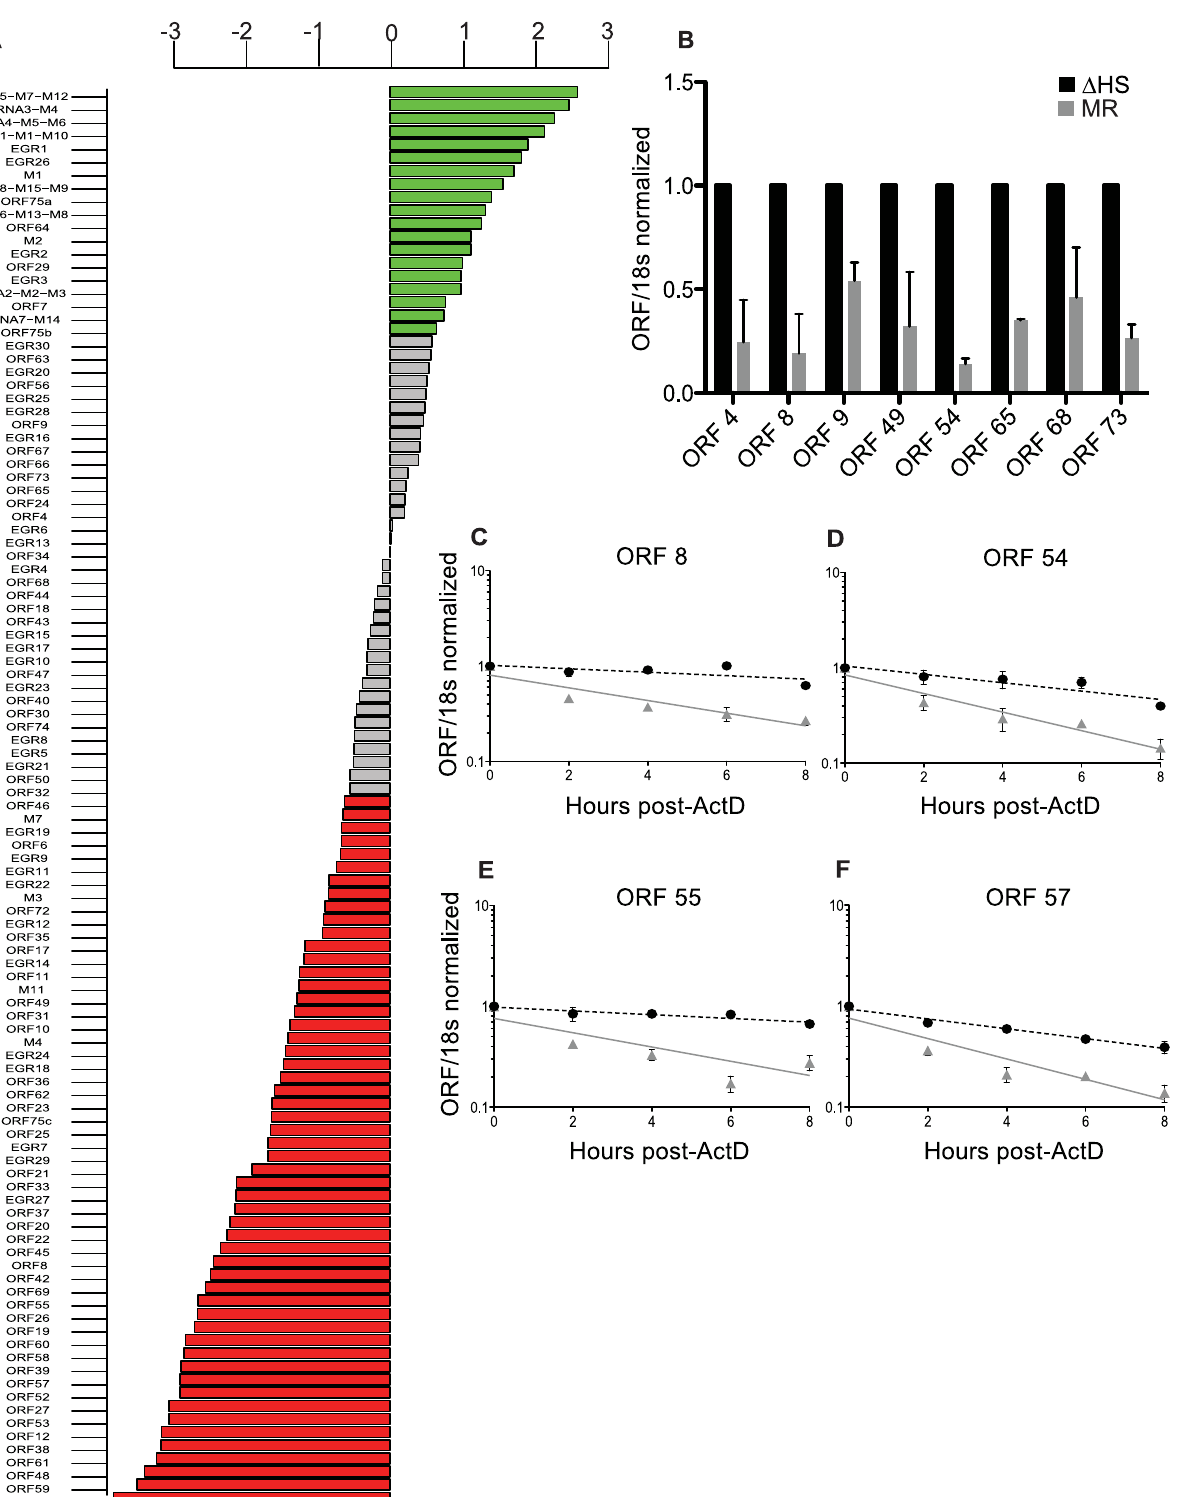
Figure 1. Expression of the majority of viral mRNAs is dampened during host shutoff. (A) For viral genes, the log 2 fold change in expression upon infection with WT compared to D HS MHV68 expression was plotted and data points were colored to indicate the adjusted P values, with green points indicating positive log 2 fold change with P value , 0.05 and red indicating negative log 2 fold change with P value , 0.05. (B) RT- qPCR was used to validate selective viral transcripts. RNA was isolated at 24 hpi from NIH 3T3 cells infected with MR or D HS MHV68 at an MOI of 5. Transcript levels were normalized to 18 s and D HS levels set to 1. (C–F) mRNA half-life analyses were conducted by infecting NIH 3T3 cells with MR or D HS MHV68 at an MOI of 5. At 18 hpi, 2 ug of Actinomycin D was added to block transcription and RNA was harvested at the indicated times thereafter. RT-qPCR was performed with ORF-specific primers and probes to determine mRNA levels. The black dotted line indicates the best-fit line for the D HS virus, and the grey solid line indicates the best-fit line for the MR virus. doi:10.1371/journal.ppat.1003882.g001 PLOS Pathogens |